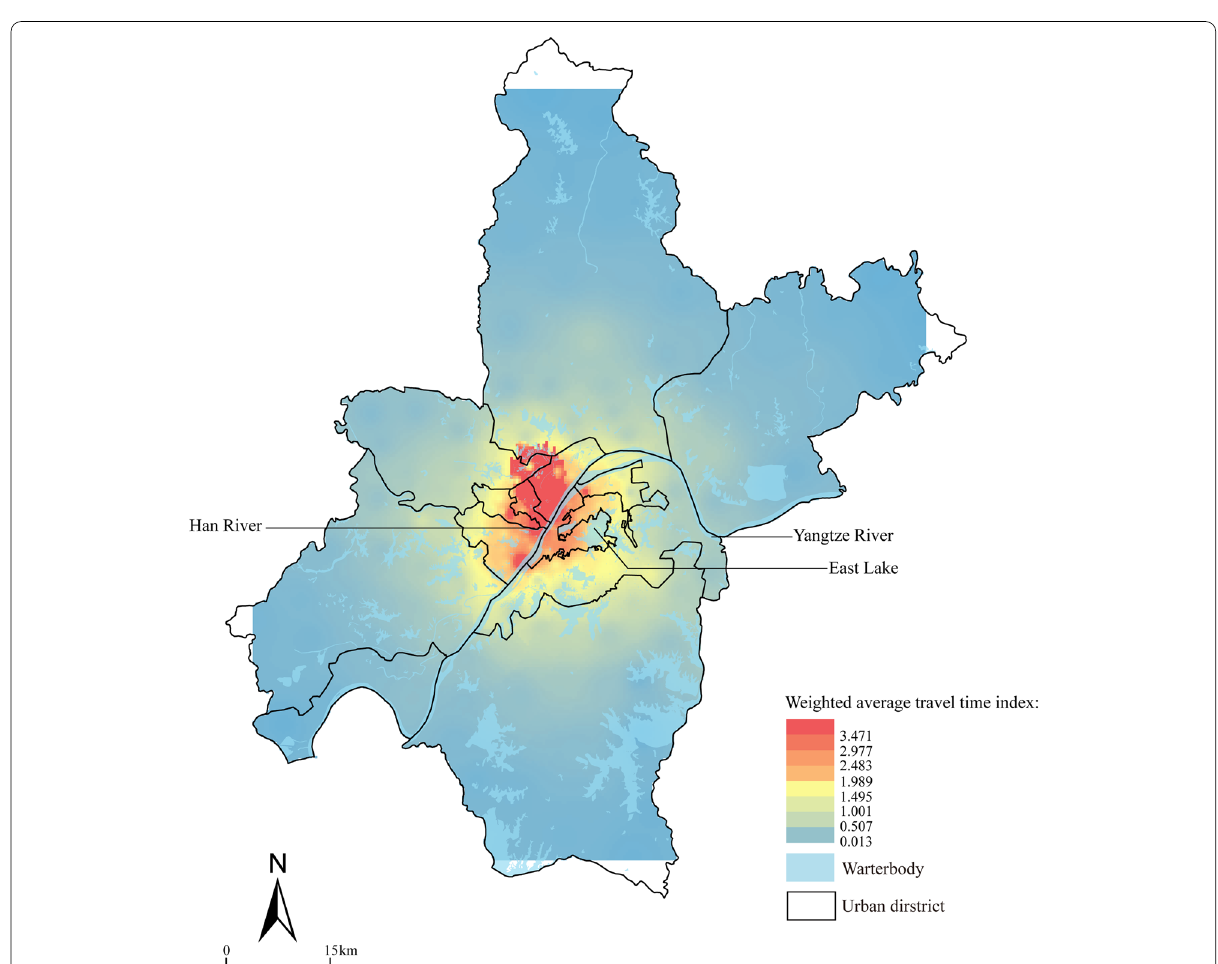
Fig. 7 The accessibility of emergency medical